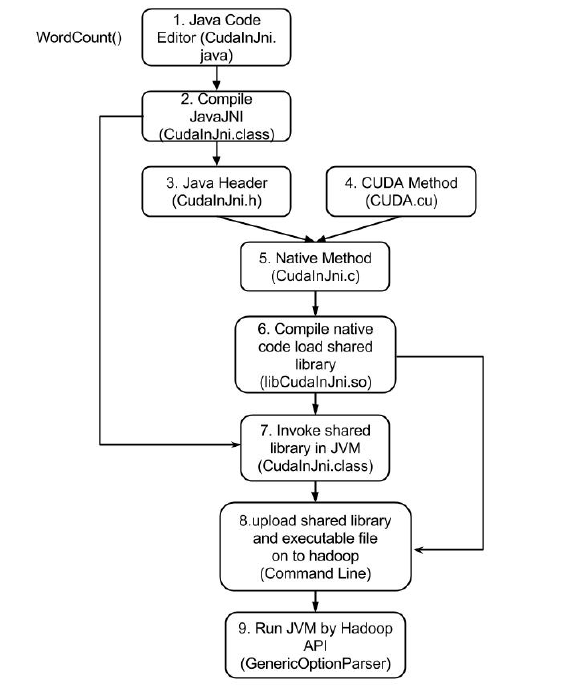
Fig. 6. Flow Chart of CUDA and Hadoop integration in